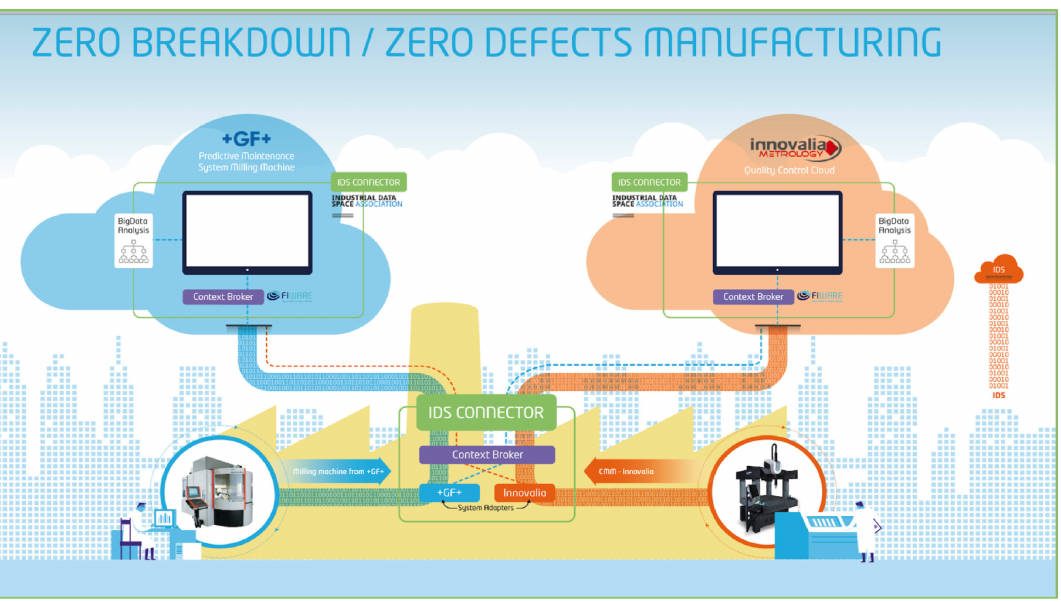
Figure 5. Use case